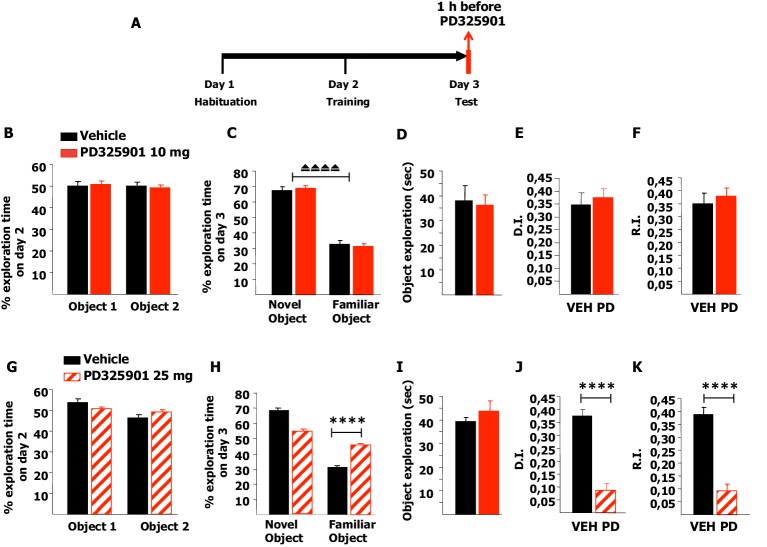
A single dose of PD325901 at 10 mg/kg does not affect retrieval of the Novel Object Recognition.(A) After a 5 min habituation session in the empty arena on day 1, mice were allowed to explore two identical objects in a 10 min training session on day 2. On the subsequent day, one hour before the test session mice received an injection of PD325901 (10 or 25 mg/kg) or vehicle and were then evaluated for their 24 hr long-term memory. (B) On day 2, no statistically significant difference was present between the basal preferences, as for both groups percentages of exploration of the two objects resulted to be comparable (Paired-samples t-test, PD325901: t9 = 0.587, p=0.572; VEH: t8 = 0.059, p=0.955). (C) On day 3, PD325901 did not alter the exploratory behaviour as the percentage of time spent exploring the novel object was significantly higher than the percentage of time spent on the familiar object for both groups, (Paired-samples t-test, PD325901: t9 = 10.886, p<0.0001; VEH: t8 = 7.424, p<0.0001), indicating a significant learning. (D) Total time of object exploration was equivalent between groups, meaning that PD325901 injection had no influence on the motivational state of the animals (Independent-samples t-test: t17 = −0.264, p=0.795). (E) The discrimination index (D.I.) of the PD325901-injected group was similar to the Vehicle injected group (PD325901: 0.375 ± 0.034, VEH: 0.347 ± 0.047; Independent-samples t-test: t17 = 0.493, p=0.628) and above chance level for both groups (One-sample t-test, PD325901: t9 = 10.871, p<0.0001; VEH: t8 = 7.426, p<0.0001), indicating that the retrieval of recognition memory was intact. (F) The recognition index (R.I.) showed that the recognition memory of the PD325901-treated group was equivalent to Vehicle treated group (PD325901: 0.380 ± 0.030, VEH: 0.349 ± 0.041; Independent-samples t-test: t17 = 0.617, p=0.545) and significantly above chance level (One-sample t-test, PD325901: t9 = 12.667, p<0.0001; VEH: t8 = 8.466, p<0.0001). PD325901 (n = 10), VEH (n = 9). (G) On day 2, no statistically significant difference was present between the basal preferences, as for both groups percentages of exploration of the two objects resulted to be comparable (Paired-samples t-test, PD325901: t9 = 0.813, p=0.437; VEH: t8 = 2.176, p=0.061). (H) On day 3, animals received an injection of 25 mg/kg of PD325901 and one hour later were evaluated in a 10 min session. For both groups, the percentage of time spent exploring the novel object was significantly higher than the percentage of time spent on the familiar object (Paired-samples t-test, PD325901: t9 = 3.286, p<0.01; VEH: t8 = 15.233, p<0.0001). Nevertheless, the time spent exploring the familiar object was significantly lower in the vehicle treated group than in the PD325901 treated group (Independent-samples t-test: t17 = 7.896, p<0.0001), indicating that PD325901 injection partially perturbed the recognition of the familiar object. (I) Total time of object exploration was equivalent between groups, meaning that PD325901 injection had no influence on the motivational state of the animals (Independent-samples t-test: t17 = 0.857, p=0.403). (J) The D.I. of the PD325901-injected group was lower, by 23.24%, indicating that 25 mg/kg of PD325901 significantly interfered with the retrieval of recognition memory (PD325901: 0.087 ± 0.027, VEH: 0.376 ± 0.025; Independent-samples t-test: t17 = −7.898, p<0.0001), although still above chance level (One-sample t-test, PD325901: t9 = 3.283, p=0.009; VEH: t8 = 15.264, p<0.0001). (K) Analysis of the R.I. showed that the percentage of time spent exploring the familiar object significantly decreased compared with the one observed during the first exposition to the same object for both groups (Paired-samples t-test, PD: t9 = 3.478, p<0.01; VEH: t8 = 10.260, p<0.0001), but the level of recognition memory in the PD325901 treated group is strongly diminished, by 23.83% (PD325901: 0.093 ± 0.027, VEH: 0.390 ± 0.027; Independent-samples t-test: t17 = −7.856, p<0.0001), although still above chance level (One-sample t-test, PD: t9 = 3.575 p<0.01; VEH: t8 = 14.672, p<0.0001). PD325901 (n = 10), VEH (n =9). ⏏⏏⏏⏏ p<0.0001, ****p<0.0001. Data are shown as mean with SEM.